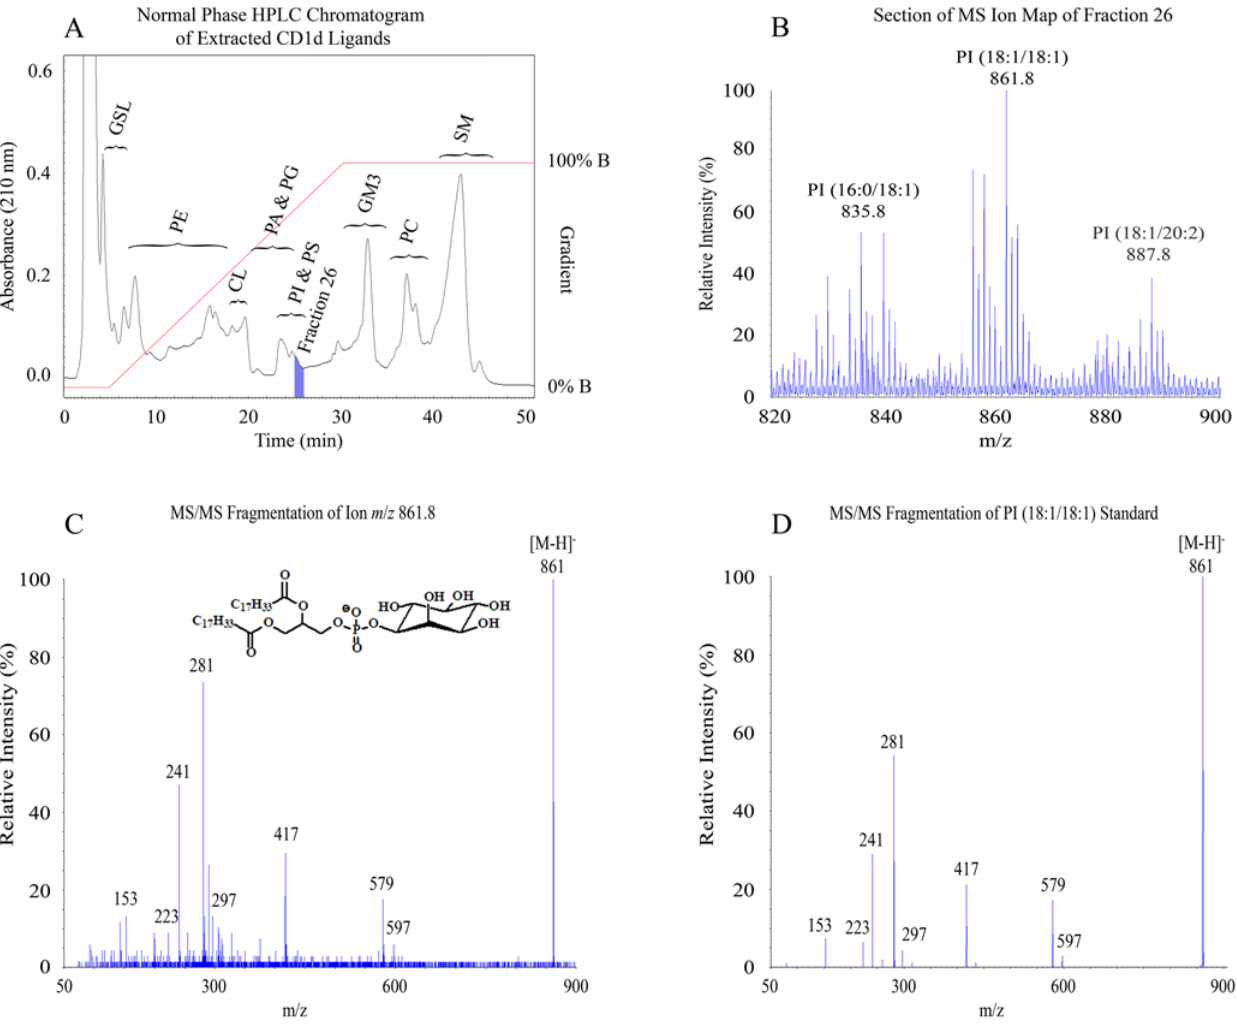
Figure 1. Isolation and characterization of ligands bound to human CD1d molecules. Secreted CD1d molecules were isolated by affinity chromatography and subject to organic extraction followed normal phase chromatographic separation (HPLC), and mass spectrometry (MS). A ) HPLC chromatogram of extracted material. The general categories of lipids found along the profile are indicated using the following abbreviations: GSL, glycosphingolipid; PE, phosphatidylethanolamine; CL, cardiolipin; PA, phosphatidic acid; PG, phosphatidylglycerol; PI, phosphatidylinositol; PS, phosphatidylserine; GM3, ganglioside GM3; PC, phosphatidylcholine; SM, sphingomeylin. B ) A section of MS ion map of fraction 26 in the negative ion mode. Ions were manually selected for MS/MS fragmentation. Within this section of the ion map three lipids were characterized, as shown by the labels above the corresponding peaks. C ) MS/MS fragmentation pattern of one of these lipids, ion m / z 861. The [M 2 H] 2 of ion 861 provides ions m / z 597 [M 2 H 2 C 16 H 31 CH=C=O] 2 (the loss of the 18:1 ketene), m / z 579 [M 2 H 2 C 17 H 33 CO 2 H] 2 (the loss of the 18:1 carboxylic acid), m / z 417 [M 2 H 2 C 16 H 31 CH=C=O 2 Ins] 2 (the loss of the 18:1 ketene and inositol), m / z 281 [C 17 H 33 CO 2 ] 2 , (18:1 fatty acid), m / z 241 [Ins-PO 3 2 H 2 O] 2 (dehydrated inositol phosphate). D ) MS/MS fragmentation pattern of synthetic PI